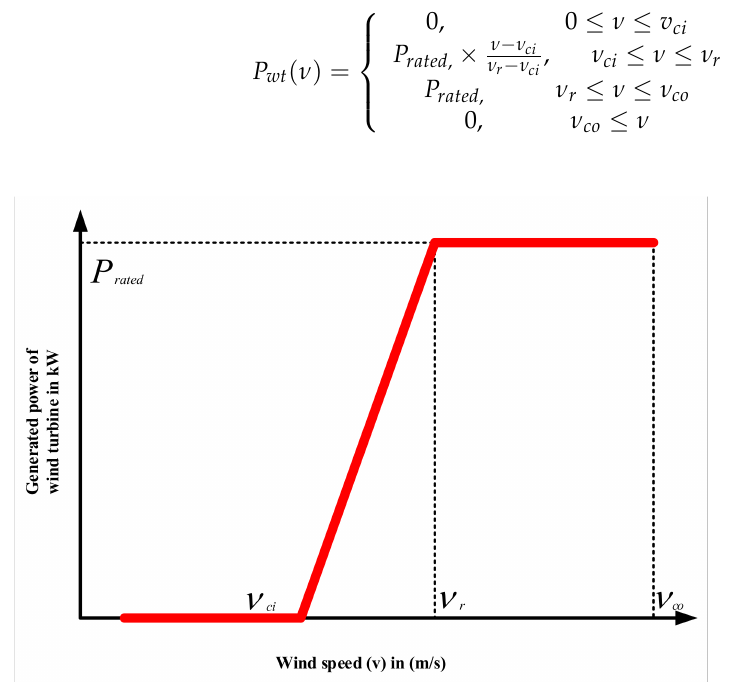
Figure 2. WT speed power